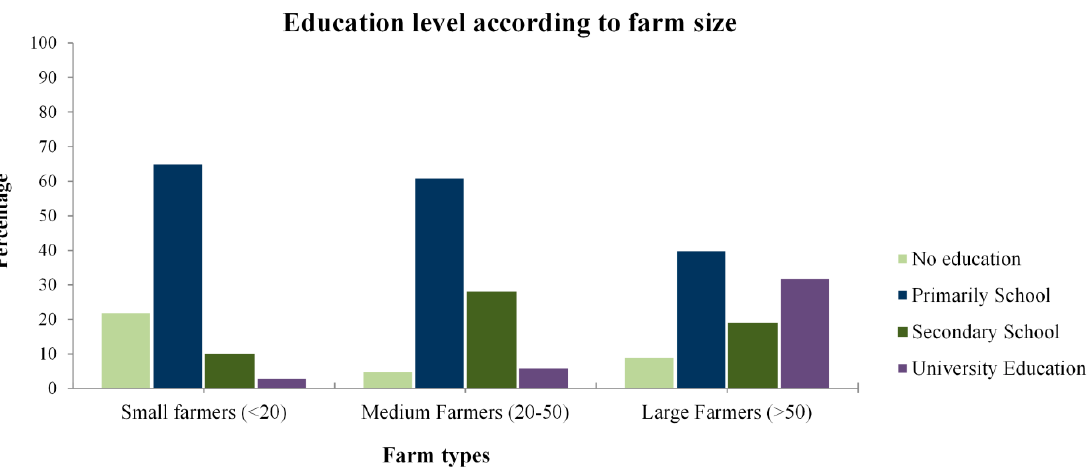
Figure 6. Education level according to farm size of the respondents